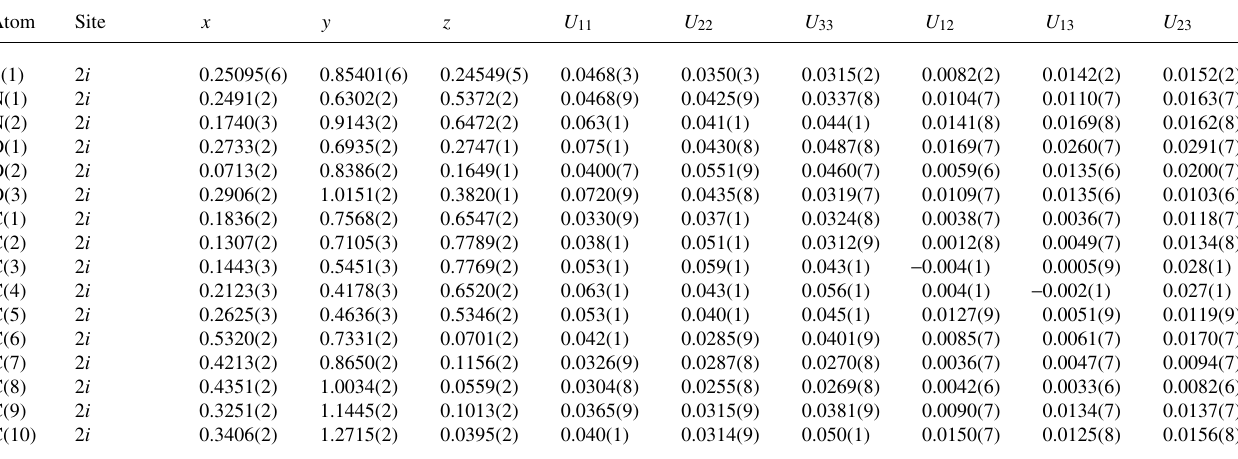
Table 3. Atomic coordinates and displacement parameters (in Å 2 )